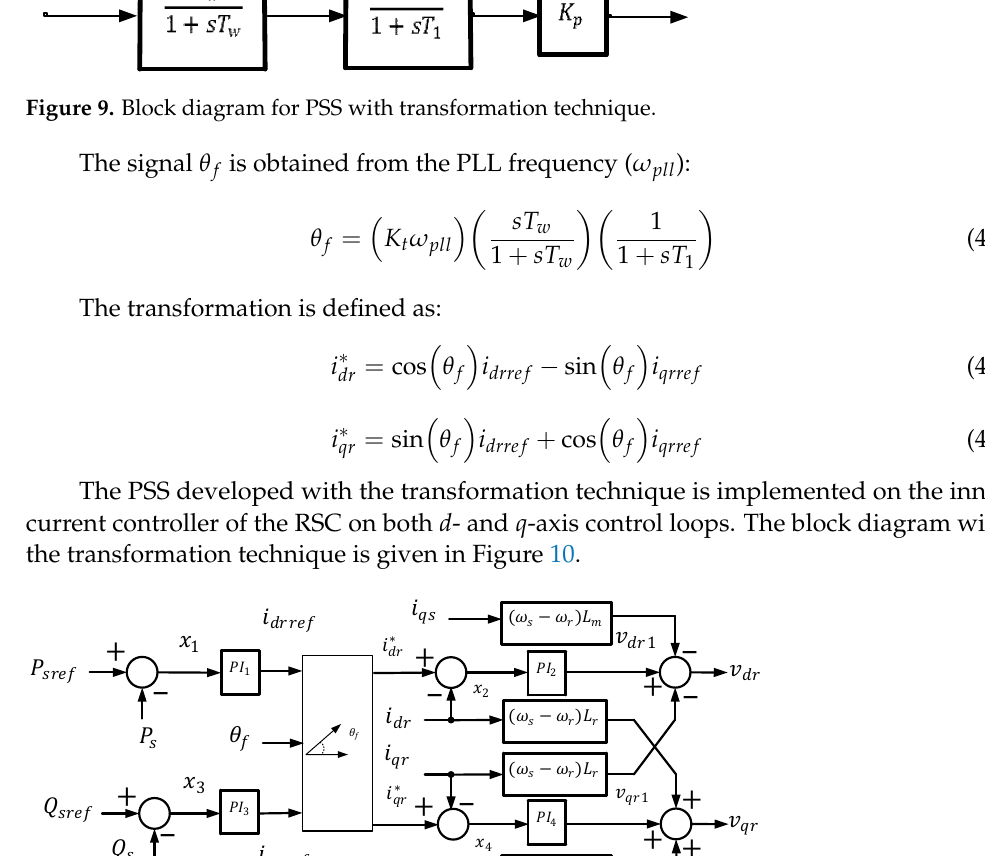
Figure 10. RSC with transformation PSS.